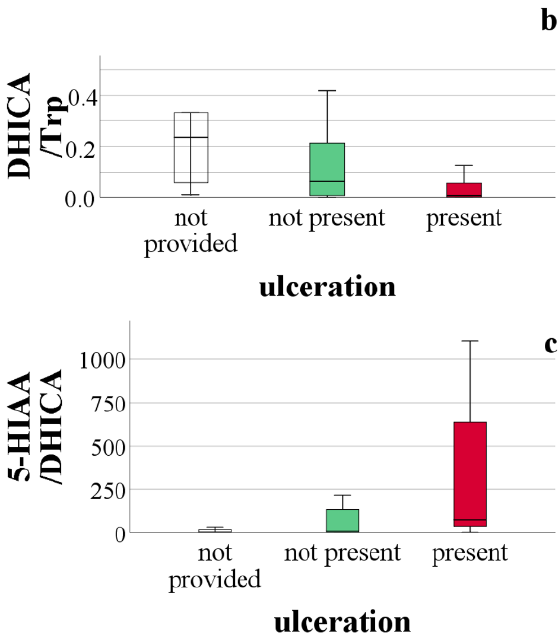
Figure 4. Comparison of serotonin pathway metabolites based on the presence of ulceration. ( a ) comparison of 5-hydroxyindole-3-acetic acid level relative to tryptophan concentration, based on the presence of ulceration, p = 0.223; ( b ) comparison of 5,6-dihydroxyindole-2-carboxylic acid level relative to tryptophan concentration, based on the presence of ulceration, p = 0.171; ( c ) comparison of 5-hydroxyindole-3-acetic acid level relative to 5,6-dihydroxyindole-2-carboxylic acid concentra- tion, based on the presence of ulceration, p = 0.210.